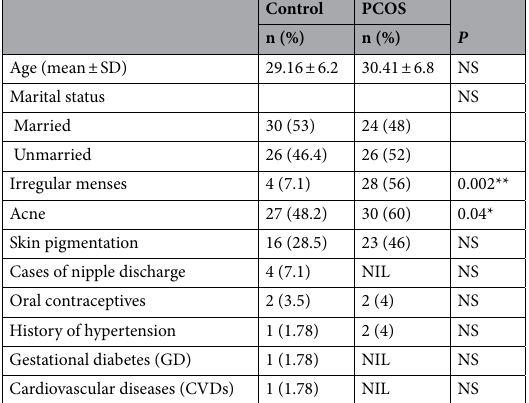
Table 1. Sociodemographic and clinical characteristics of the study groups. NS, non-significant. * p ≤ 0.05, ** p ≤